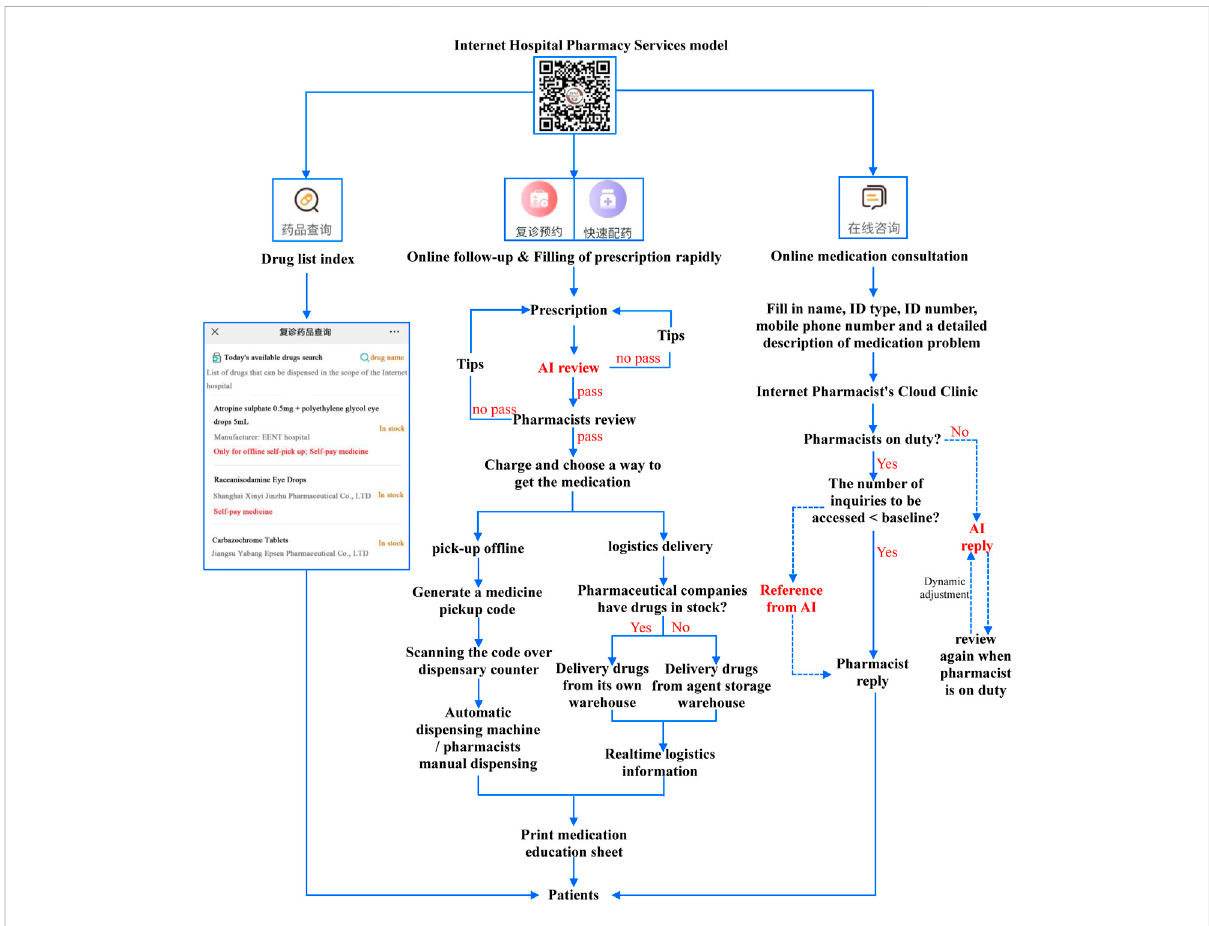
FIGURE 2 Established AI+ internet hospital pharmacy services